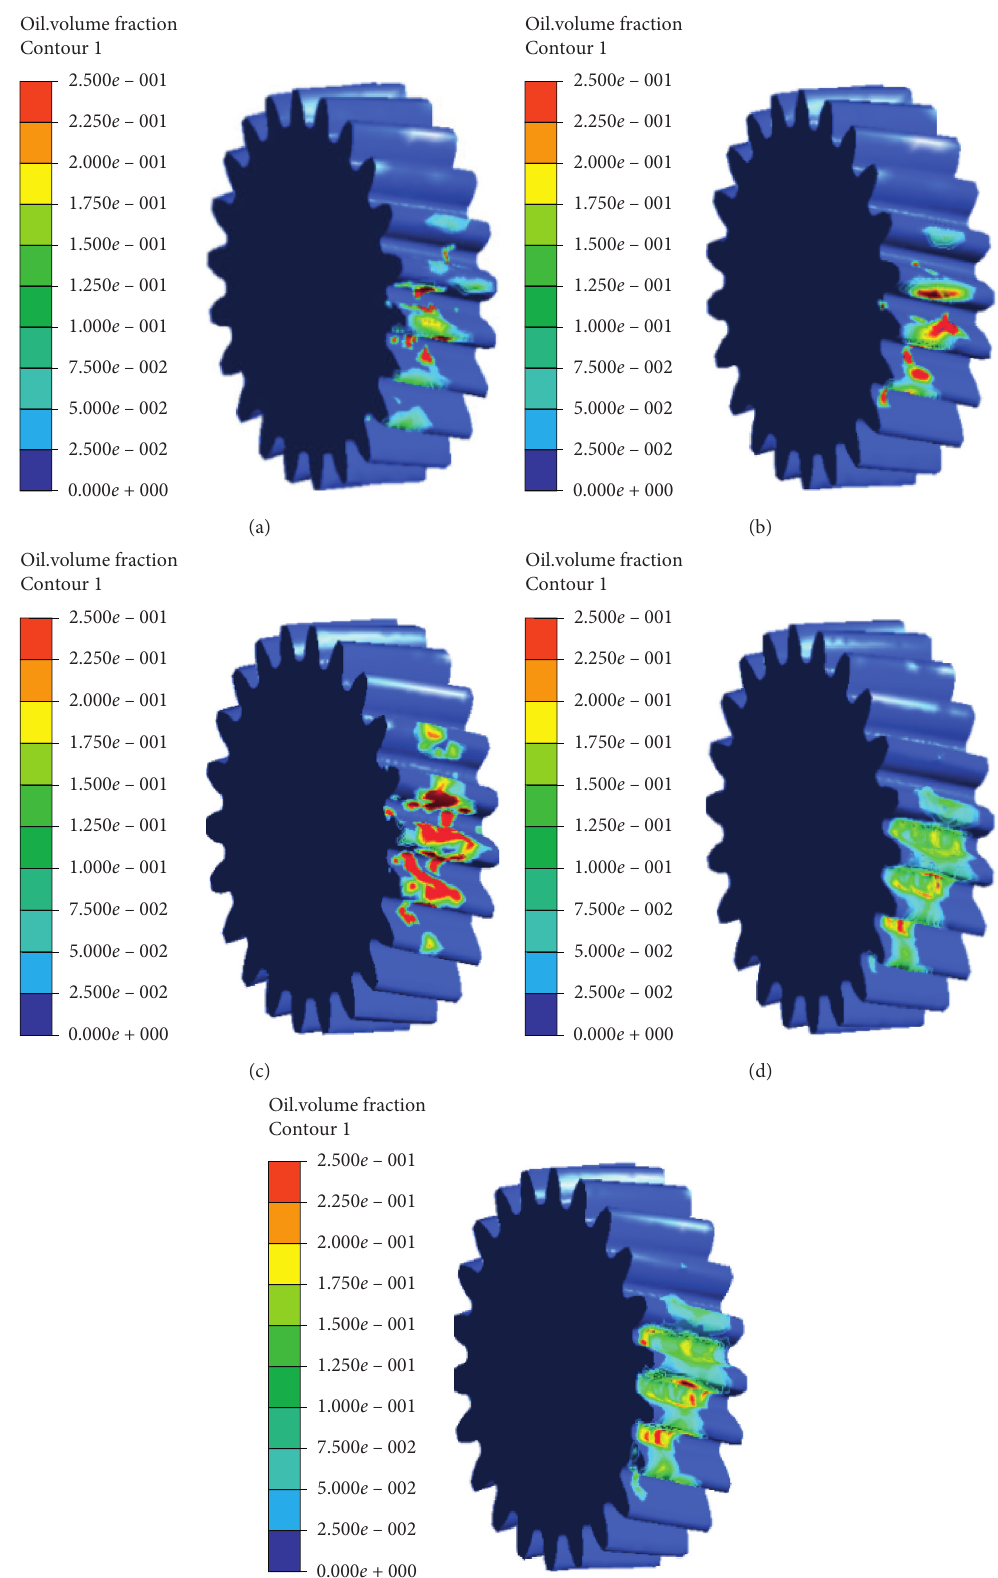
Figure 9: Oil distribution on driving gear tooth surface: (a) 20m/s; (b) 25m/s; (c) 30m/s; (d) 35m/s; (e)